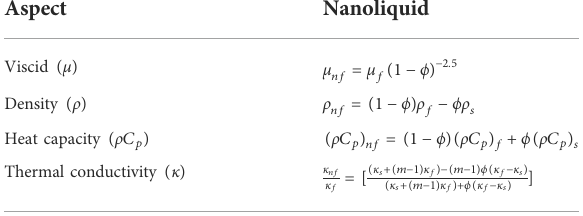
TABLE 1 Thermo-physical properties of PENF.